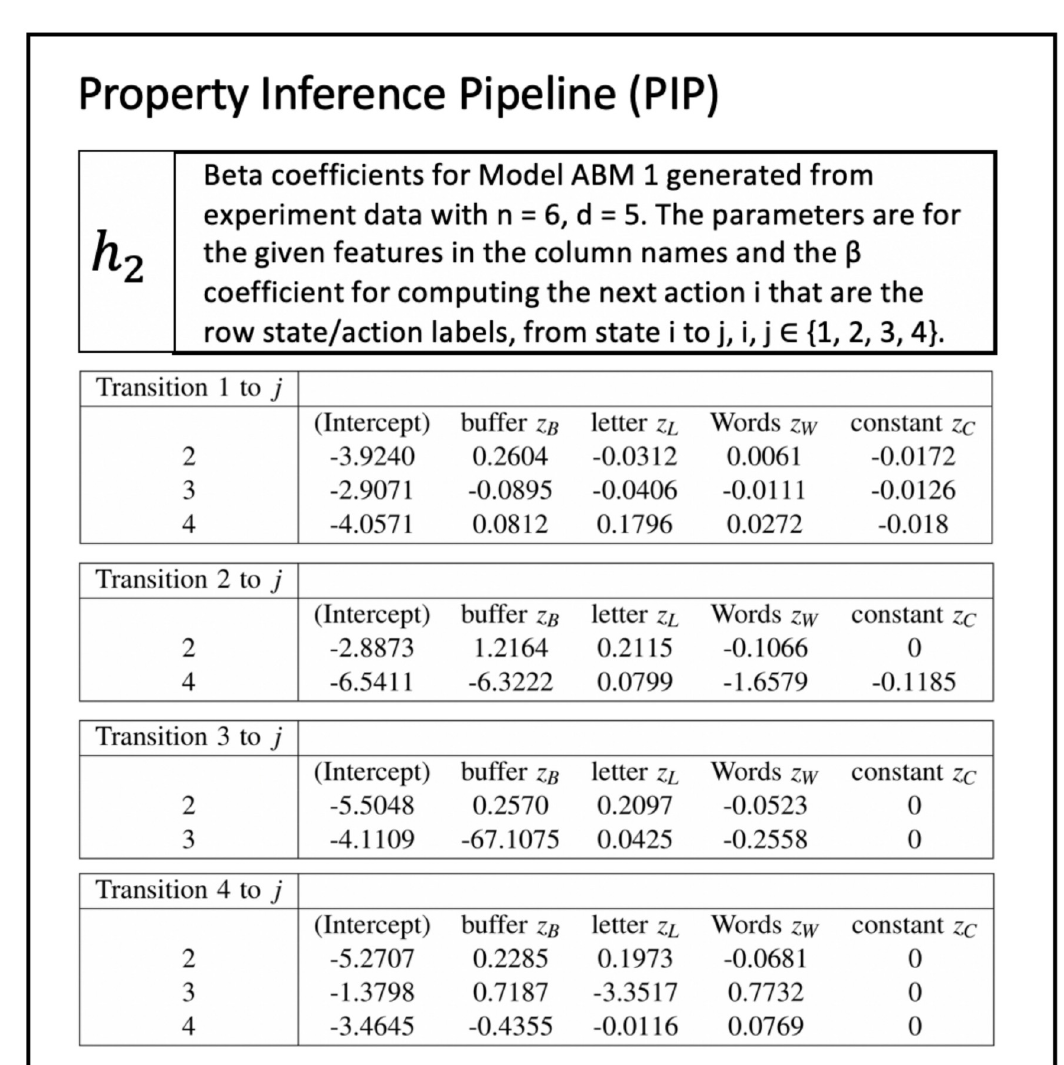
Fig 17. The Property Inference pipeline receives the input from h 7 of the Data Analysis Pipeline (DAP). The parameters in this figure were generated to inform an ABM model for the Modeling and Simulation Pipeline (MASP). The transitions in the figure are from from i to j , where a i 2 A is the action at time t and a j 2 A is the action at ( t + 1). Rows not shown mean there are no such transitions in the